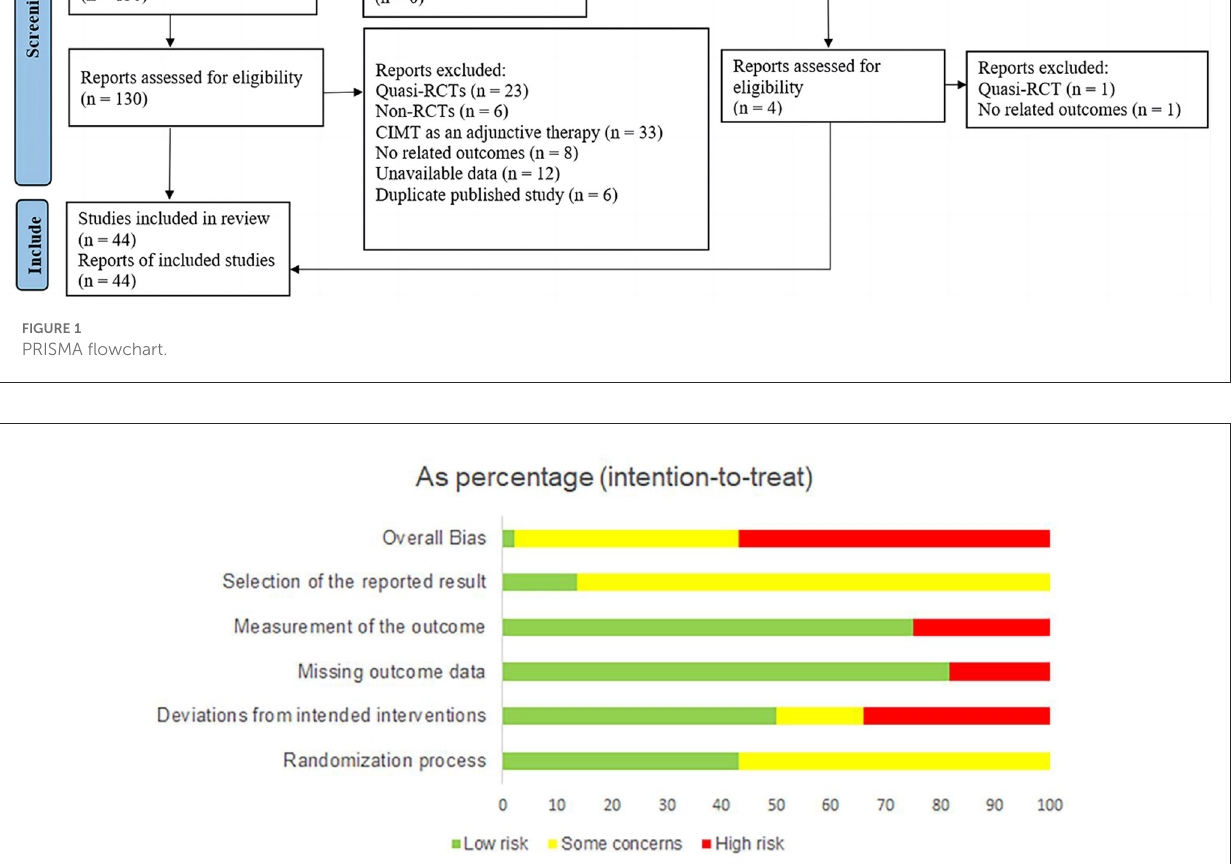
FIGURE2 Risk-of-bias summary.